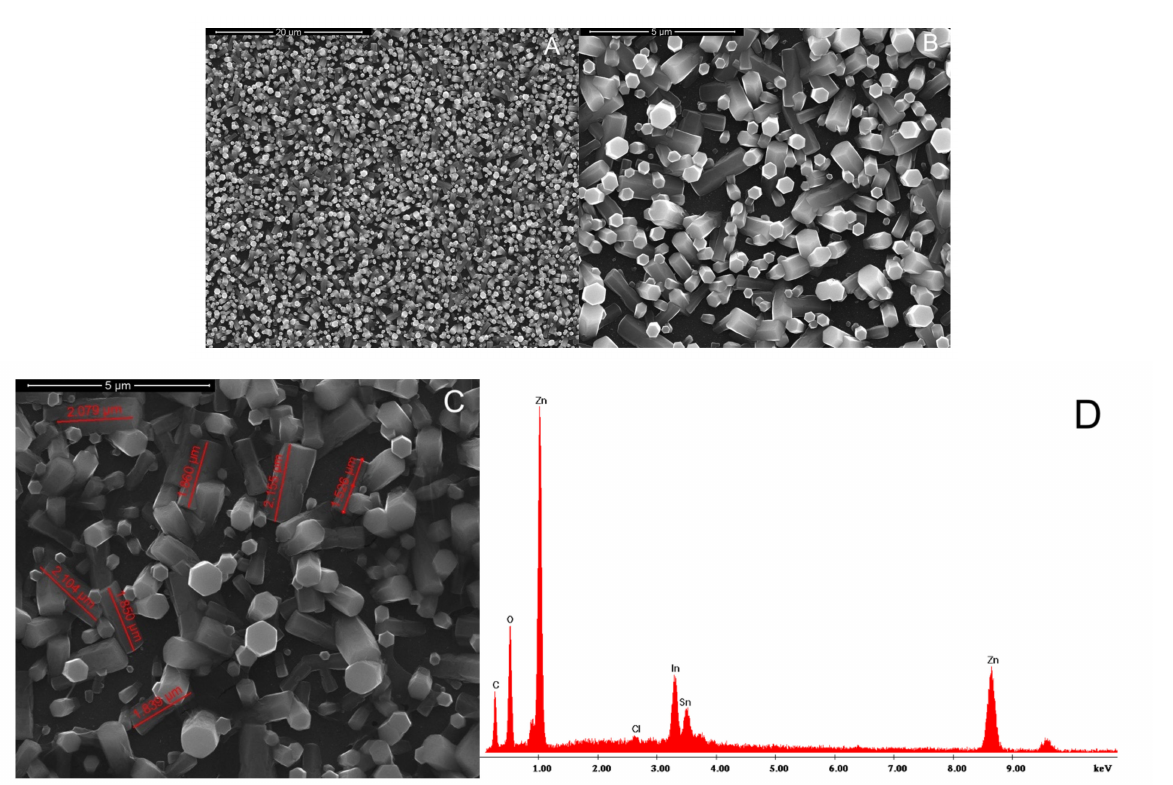
Figure 6. SEM images ( A – C ) of ZnO nanorods and ( D ) EDS spectrum of the optimized electrode. The electrode was obtained at − 0.95 V vs. Ag/AgCl for 60 min in a de-aerated solution of 10 mM ZnCl2 and 10 mM NaNO 3 at pH